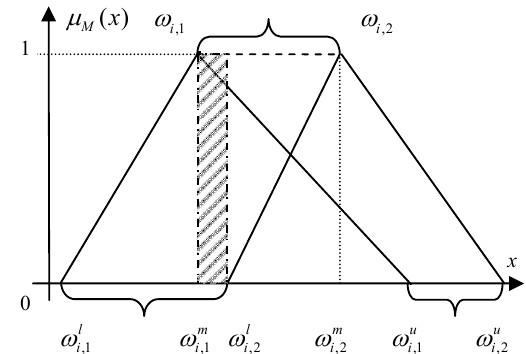
Fig. 4. One case of combining two triangular fuzzy weights from 2